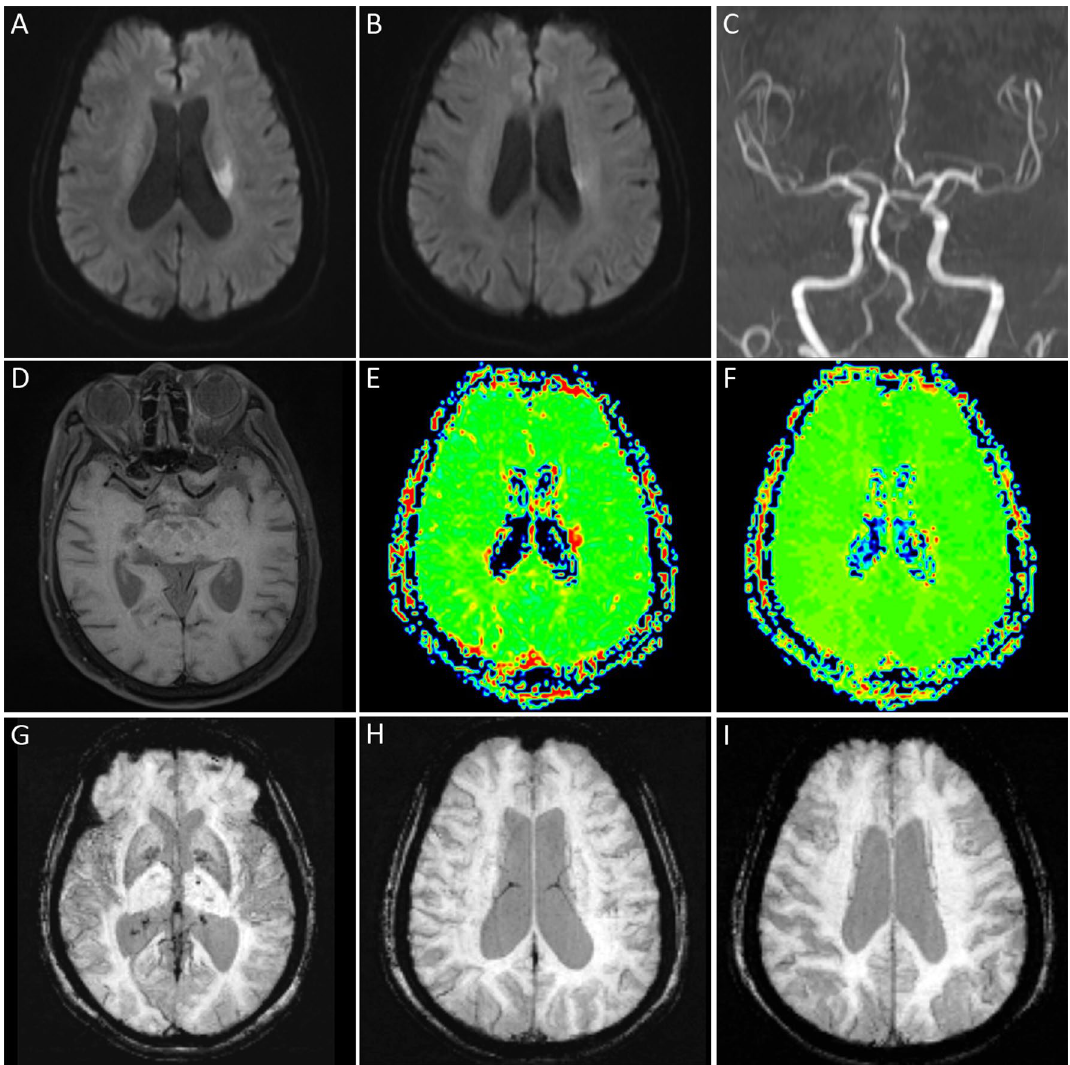
Figure 2. Prominent vessel sign was not displayed in a patient with perforator occlusion in the anterior circulation. DWI ( A , B ) showed lacunar infarction in the left paraventricular region. Large vessel occlusion was not seen on MRA ( C ) and 3D-SPACE ( D ). The MTT ( E ) and TTP ( F ) maps indicated a small area of hypoperfusion near the left lateral ventricle. There was no prominent vessel sign on SWI ( G – I